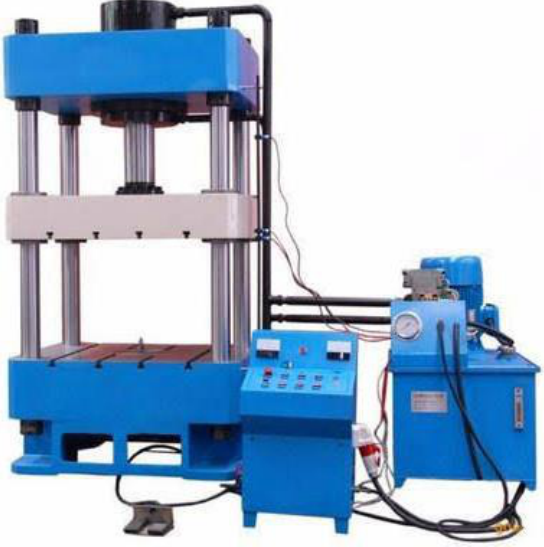
Figure 2. ( a ) Stir casting set up. ( b ) Spray forming setup.